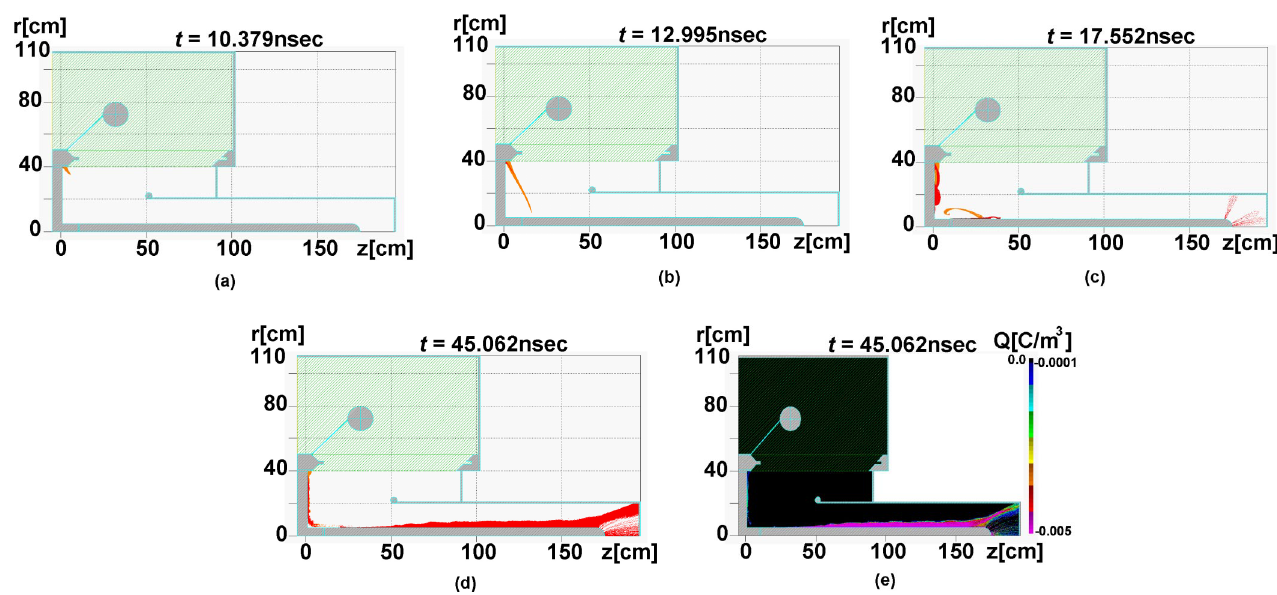
FIG. 16. (Color) PIC calculated phase space of all electrons at t (cid:5) 10 : 379 (a), 12.995 (b), 17.552 (c), and 45.062 (d) nsec for the system of Fig. 14. In (e) the charge density contours are drawn at the same time instant as in